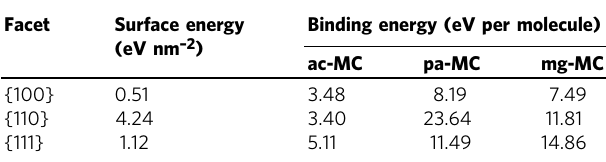
Table 1 Calculated surface energies and ligand binding energies for the different facets of Fe 3 O 4